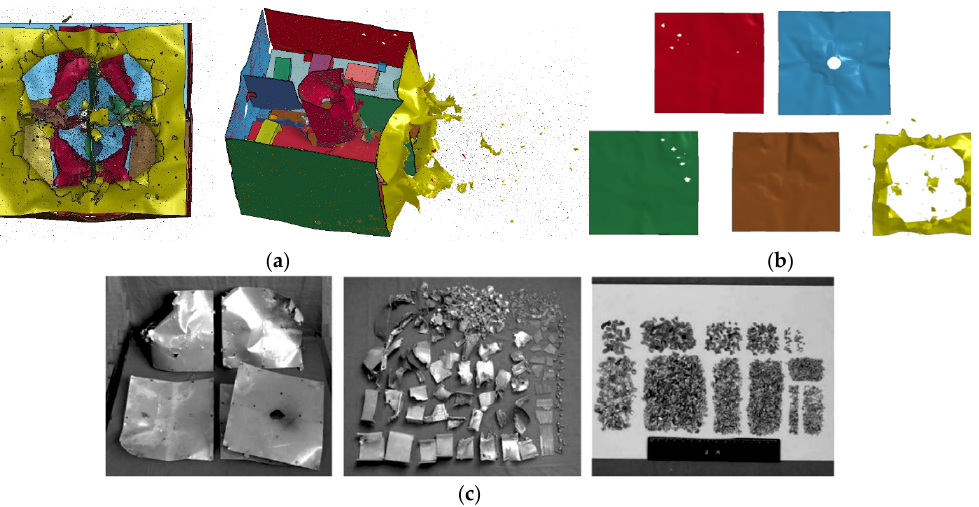
Figure 27. Comparison of satellite’s overall breakup and structural component damage between simulation and test. ( a ) Simulation graphs of the overall breakup of satellite; ( b ) simulation graph of damage of satellite’s structural components; ( c ) test photos of satellite’s overall breakup and structural component damage